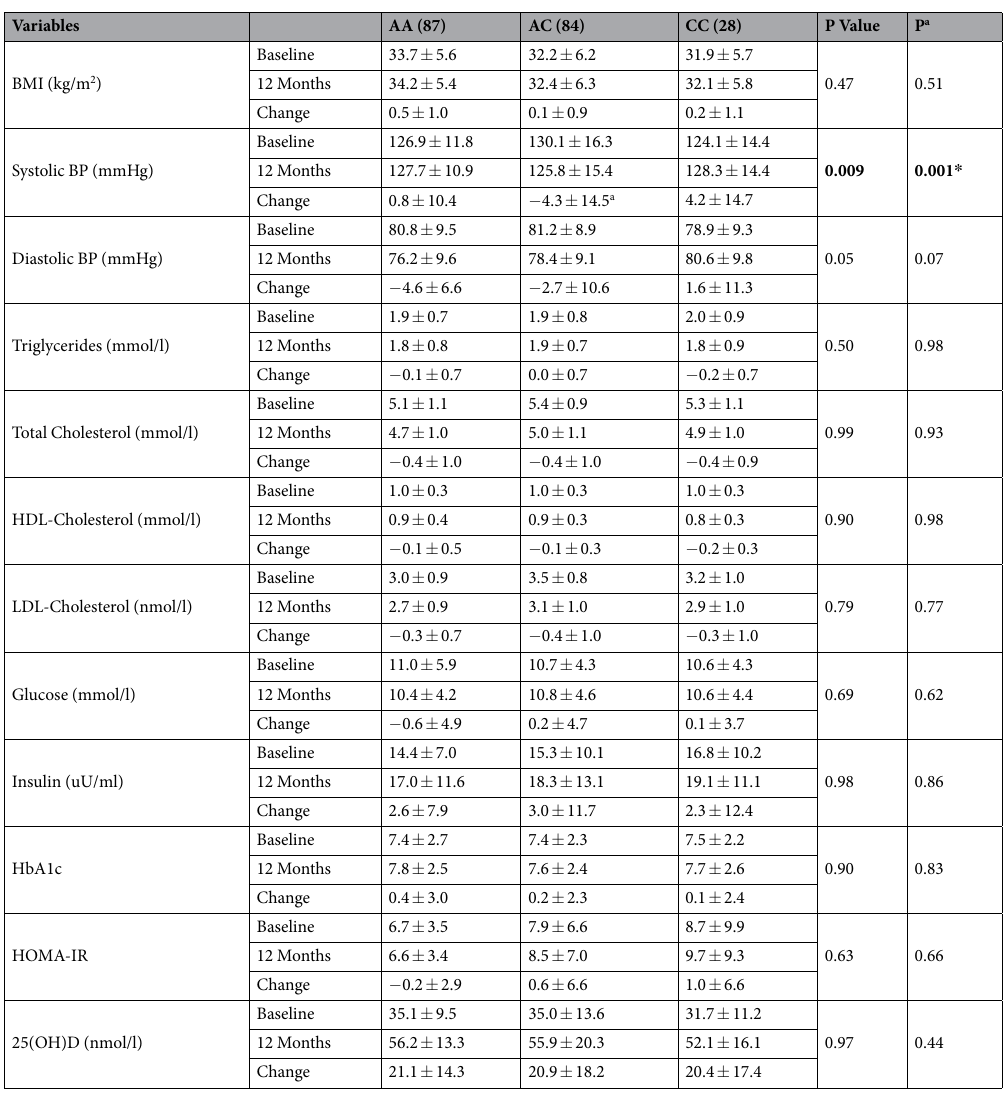
Table 6. Comparisons of the variables among the Apa-I genotypic before and after 12 months of vitamin D supplementation. Note: Change = Follow up − Baseline; p values presented are for the changes in different variables after vitamin D supplementation according to Apa-I genotypes; P a indicates p values after adjusting age, gender, BMI and baseline 25(OH)D levels; Superscript “a” indicates significantly different from AA group after post hoc analysis; “ * ” indicates p < 0.05 after Bonferroni